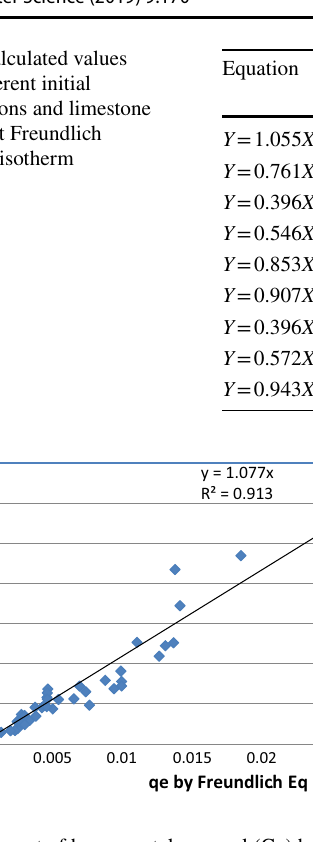
on the x -axis, the best-fit straight line has a slope of N , and Ln( K ) is its intercept. When N = 1, the Freundlich f isotherm, represented by Eq. (2), reduces to a linear rela- tionship. The adsorption data obeyed Freundlich adsorp- tion isotherm, the plot of Ln ( q ) vs Ln ( C ), from Fig. 9, e e is linear, and Freundlich constants K and n obtained f are 0.007 and 2.525, respectively (for limestone size of 9.5 mm and initial concentration 1.72 mg/l). Because